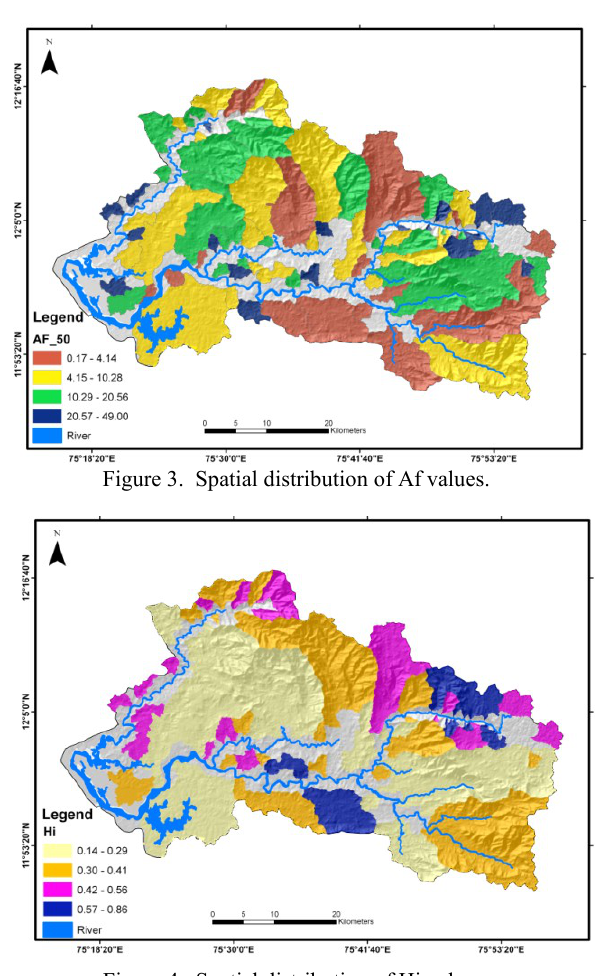
Figure 4. Spatial distribution of Hi values.